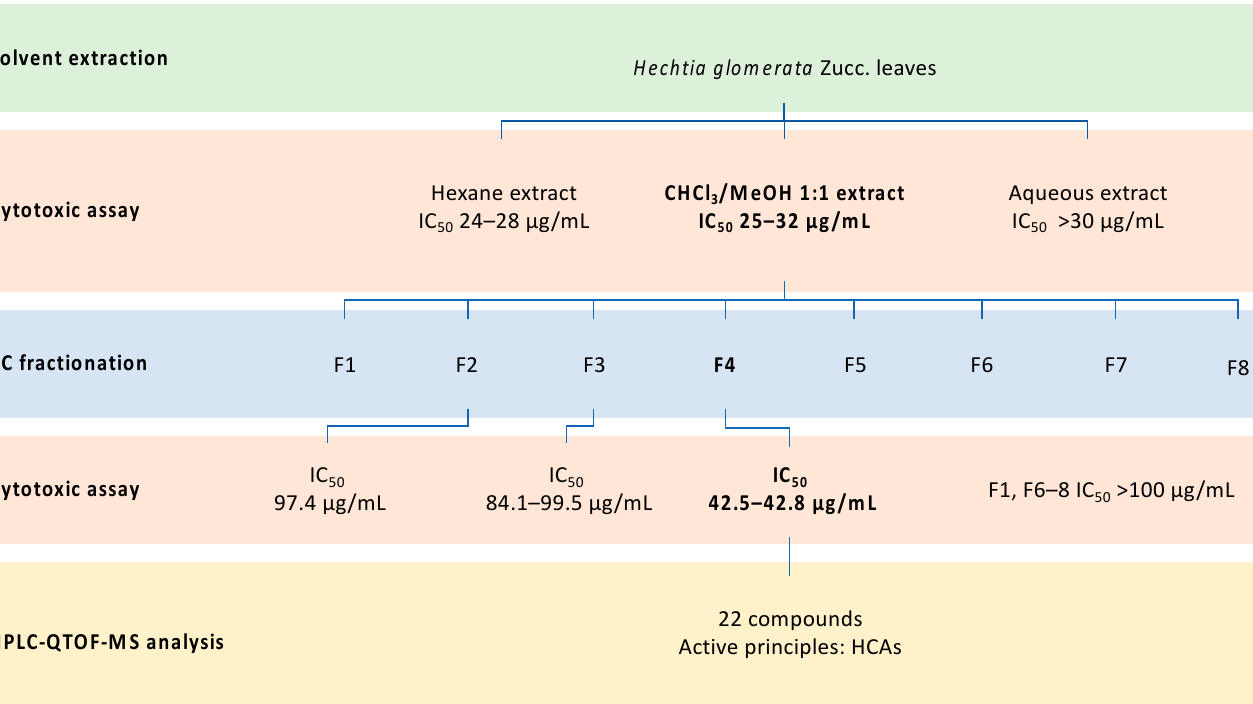
Figure 3. Bioassay-guided fractionation procedure: exhaustive solvent extraction of vegetal material; cytotoxic assays of obtained extracts; column chromatography (CC) fractionation of active extract; cytotoxic assays of fractions against cancer cell lines affected by the whole extract; high-performance liquid chromatography-quadrupole/time-of-flight-mass spectrometry (HPLC-QTOF-MS) analysis of active fraction.